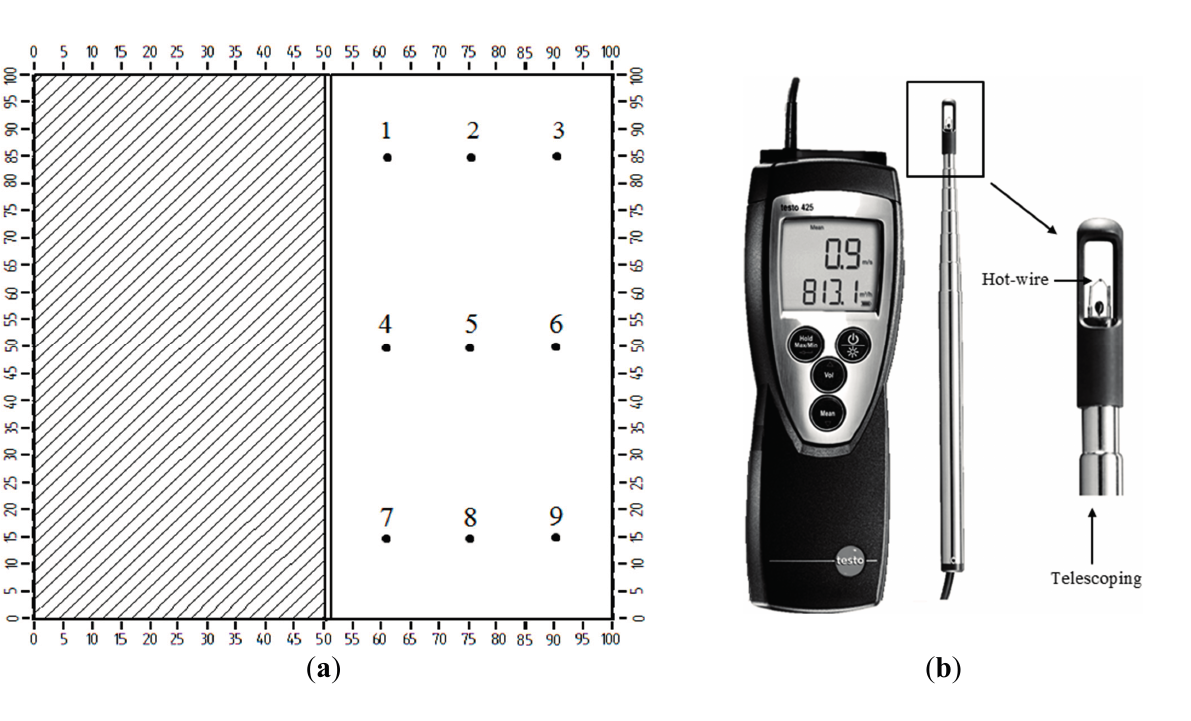
Figure 13. ( a ) Measurement points; ( b ) Hot-wire